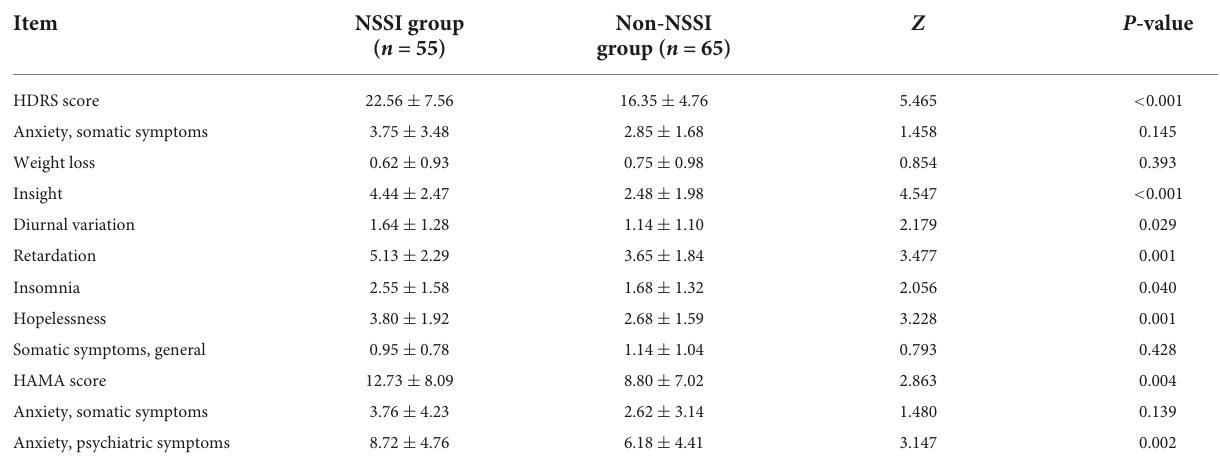
TABLE 2 HDRS and HAMA